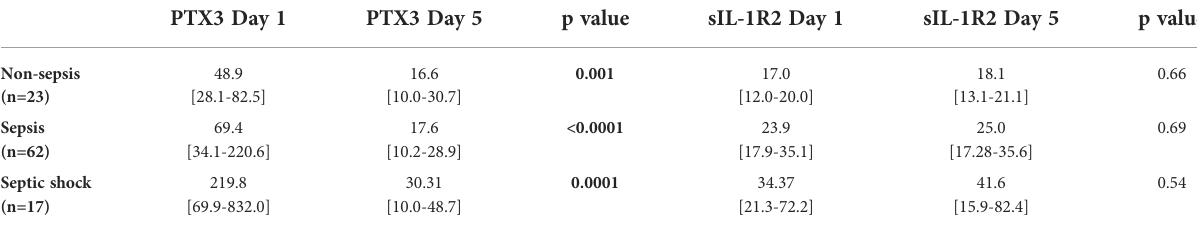
TABLE 2 PTX3 and sIL-1R2 levels at day 1 and day 5 in non-sepsis, sepsis and septic shock